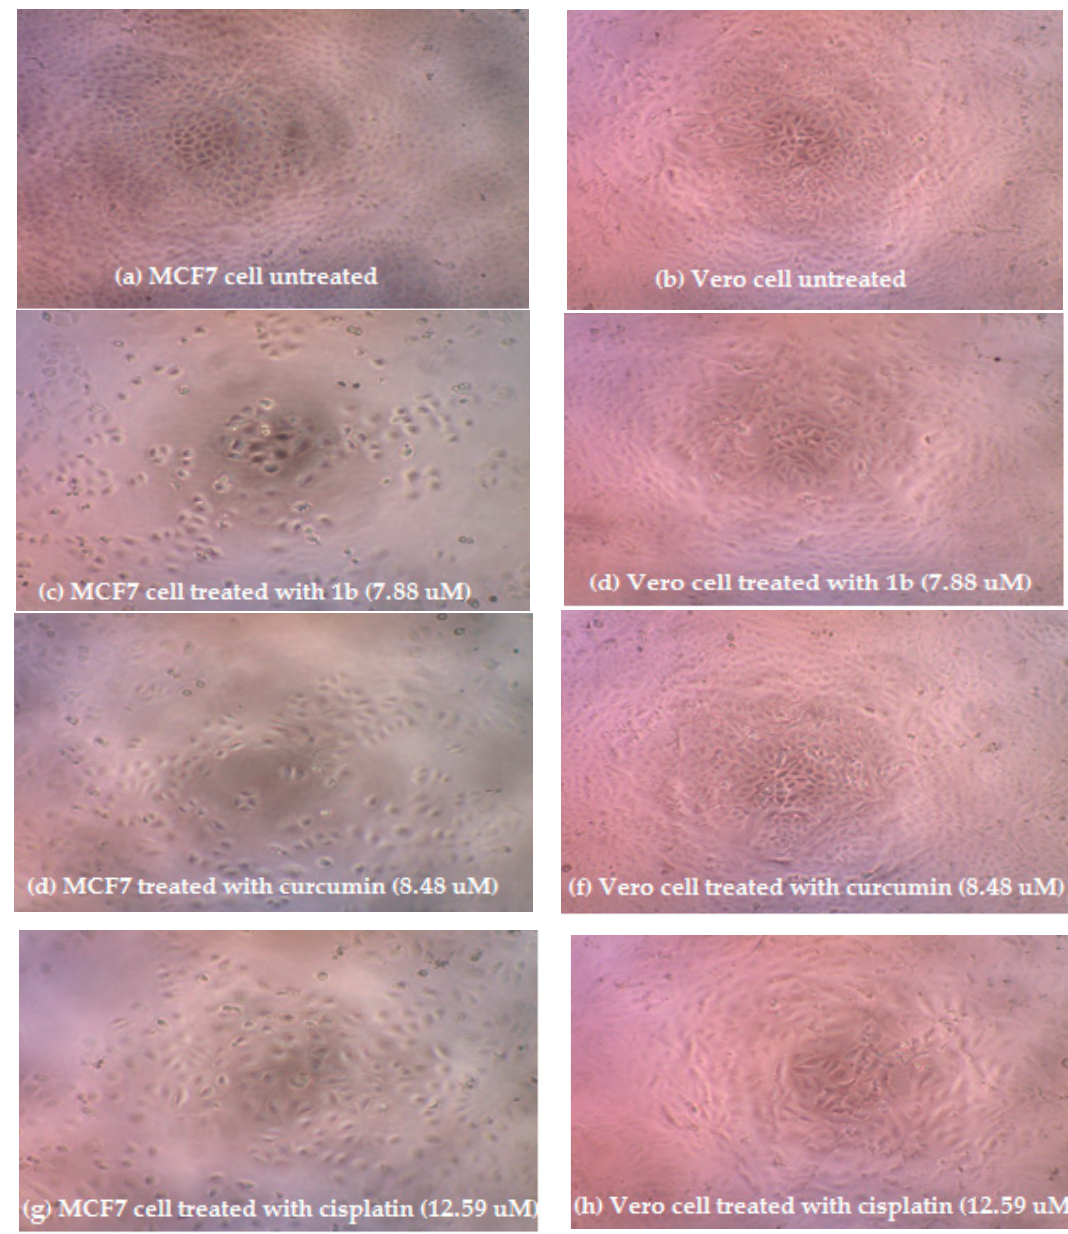
Figure 2. Morphological assessment of MCF7 cells (left) and Vero cells (right) using MTT assay. ( a , b ) untreated cells; ( c , d ) cells treated with compound 1b at 7.88 µM; ( e , f ) cells treated with curcumin at 8.48 µM; and ( g , h ) cells treated with cisplatin at 12.59 µM.